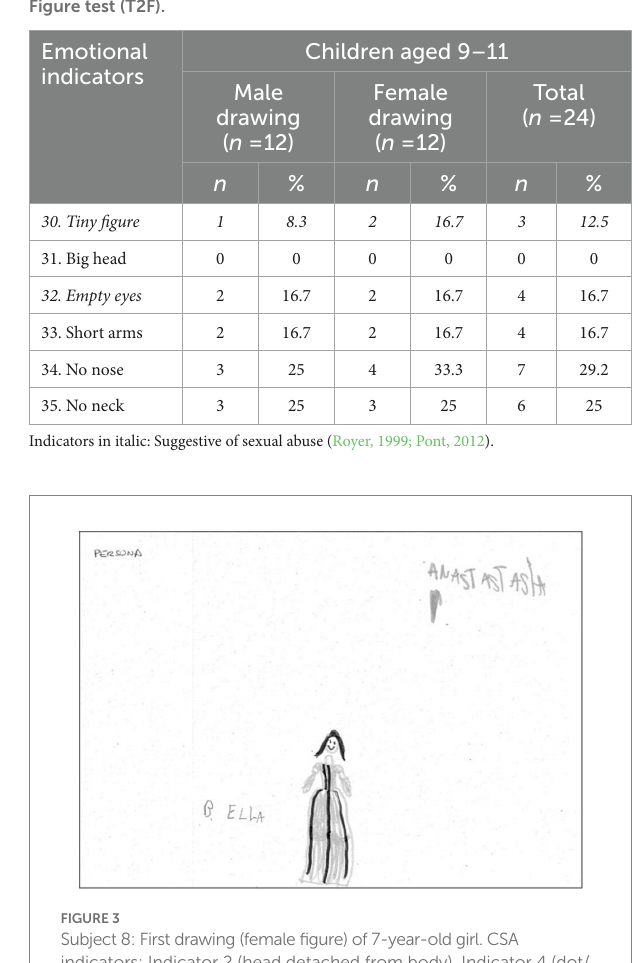
figure as a first drawing (see Figure 3) which presented three indicators of sexual abuse (CSA) and four emotional indicators (T2F). These indicators of child sexual abuse (CSA) are as follows: (2) head detached from body, (4) dot/shaded eyes, (5) hands and/or arms cut off/omitted; while the emotional indicators are (17) shading of body, (18) shading of limbs, (24) poorly integrated figure and (26) hands cut off. She was then asked to draw figure of the opposite sex, that is a male. This second drawing of the second human figure (see Figure 4) represented a male figure with genitals and added a very small female figure, with transparencies in the genital area. This male figure has one indicator of sexual abuse (CSA) and four emotional indicators (T2F). The indicator of sexual abuse (CSA) was indicator (6) genitals, while the emotional indicators were are as follows: (4) two or more figures, (7) transparencies, (14) genitals or emphasised sexual features and (17) shading of the body.